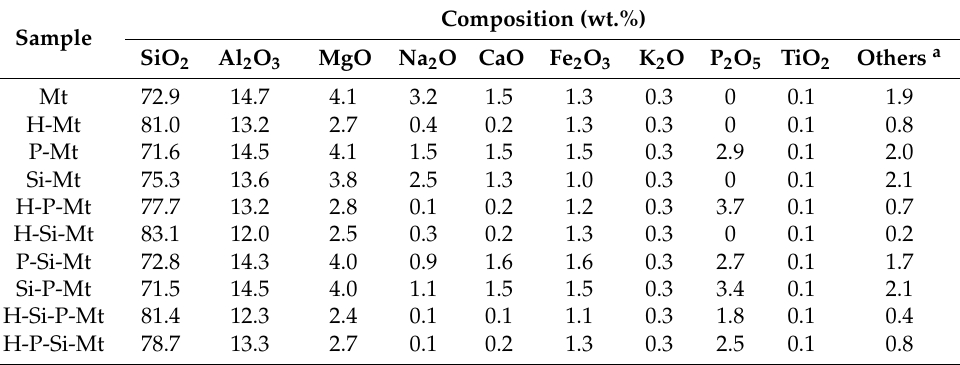
Distribution of the composition of Mt and functionalized Mt samples found by XRF